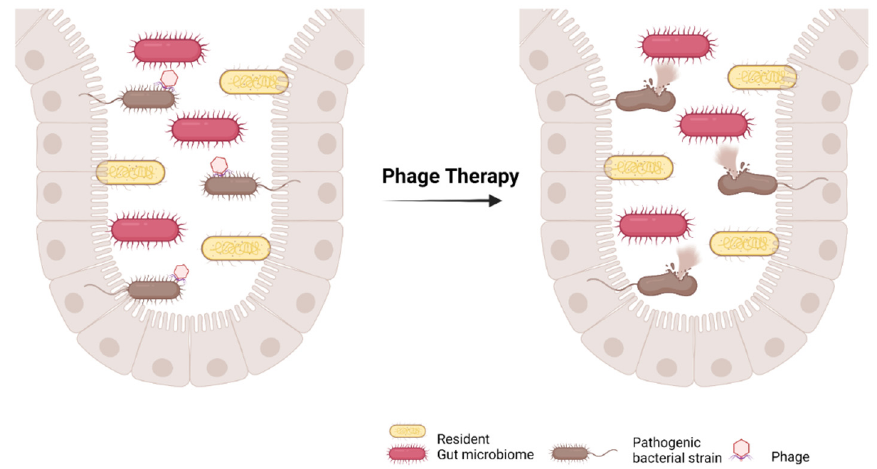
Figure 4. Traditional phage therapy for gut dysbiosis with pathogenic microbiome.